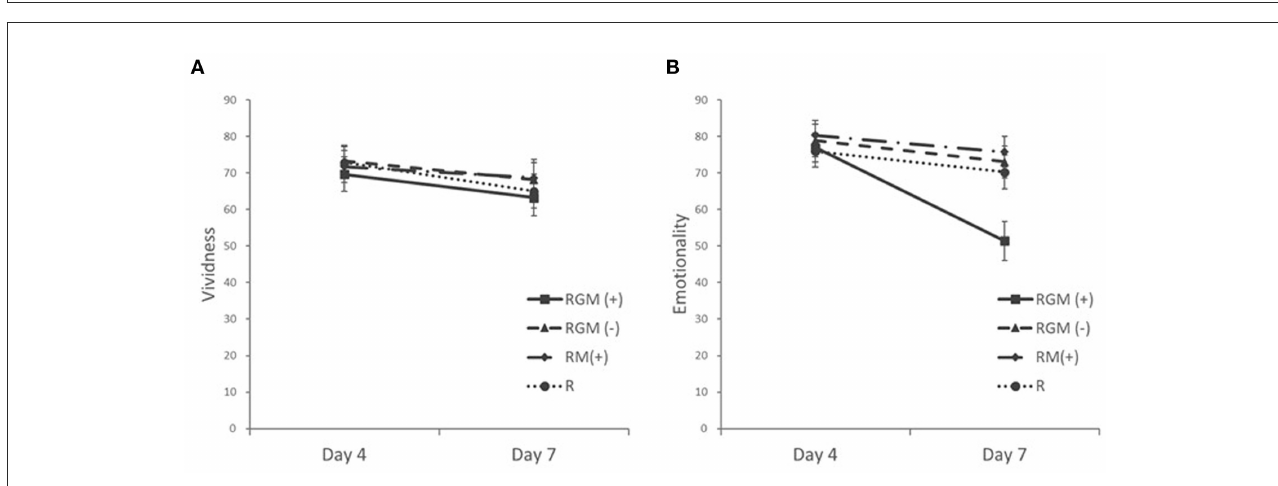
FIGURE4 Mean vividness (A) and emotionality (B) ratings at pre-intervention (Day 4) and post-intervention (Day 7). Error bars depict SEMs.